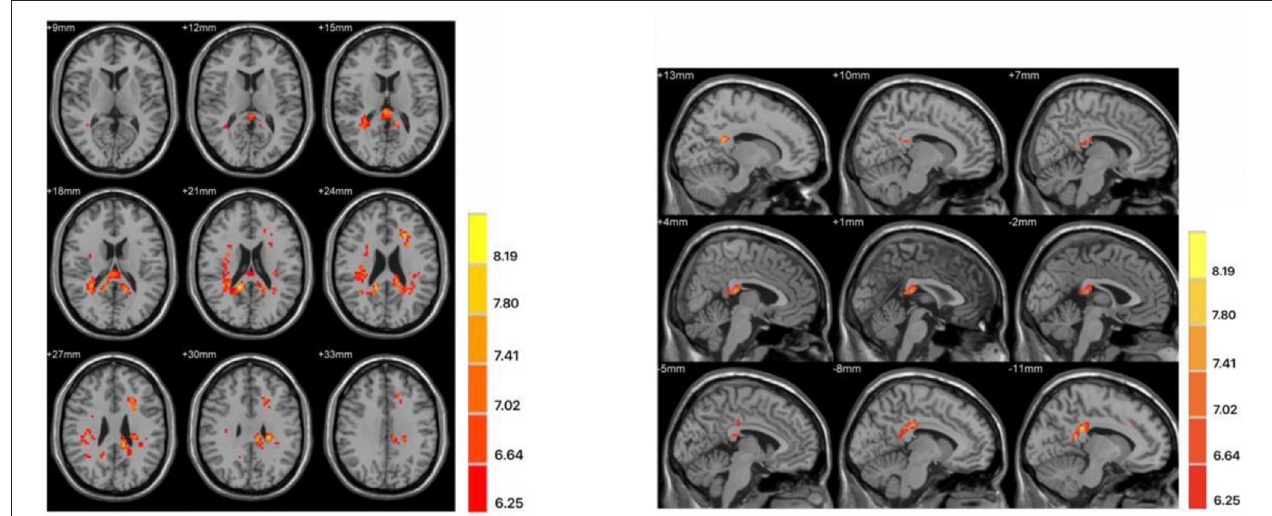
FIGURE 1 | Differences in fractional amplitude of low-frequency fluctuation (fALFF) values between first-episode major depressive disorder patients and healthy controls. Increased fALFF values (left mid cingulum, right precuneus, and left superior frontal gyrus) were presented on the red color, and the color bar indicates the T values of the group analysis. Left: transverse plane; Right: sagittal plane.